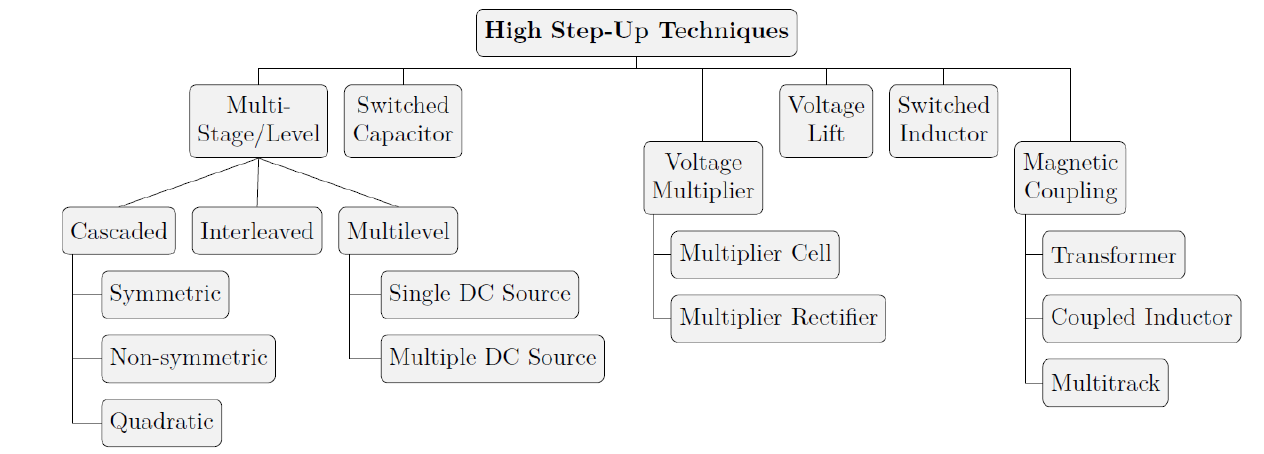
Figure 1. Classification of High Step-Up Techniques Families.